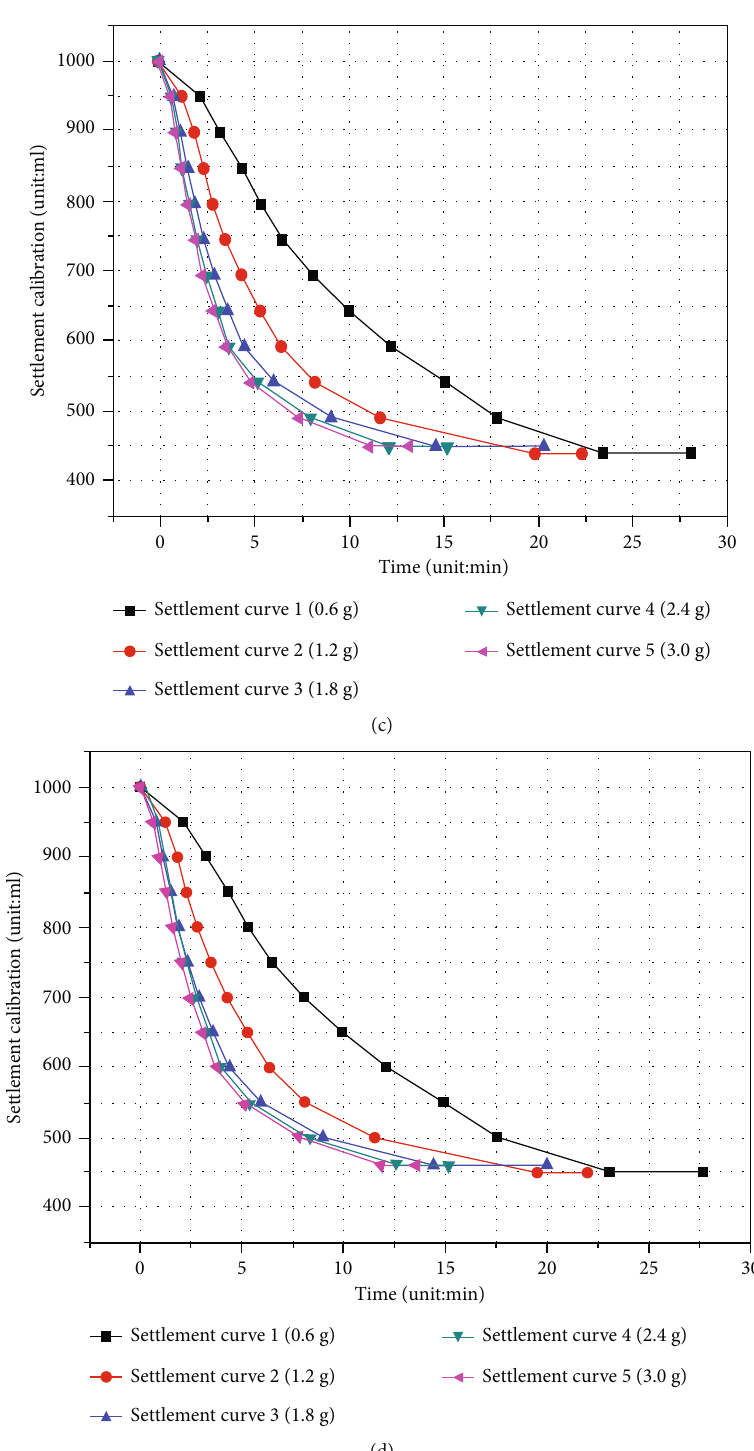
Figure 4: The settlement curve of tailings at di ff erent time: (a) the fl occulant concentration was 0, (b) the fl occulant concentration was 0.2g/1000ml, (c) the fl occulant concentration was 0.3g/1000 ml, and (d) the fl occulant concentration was 0.5